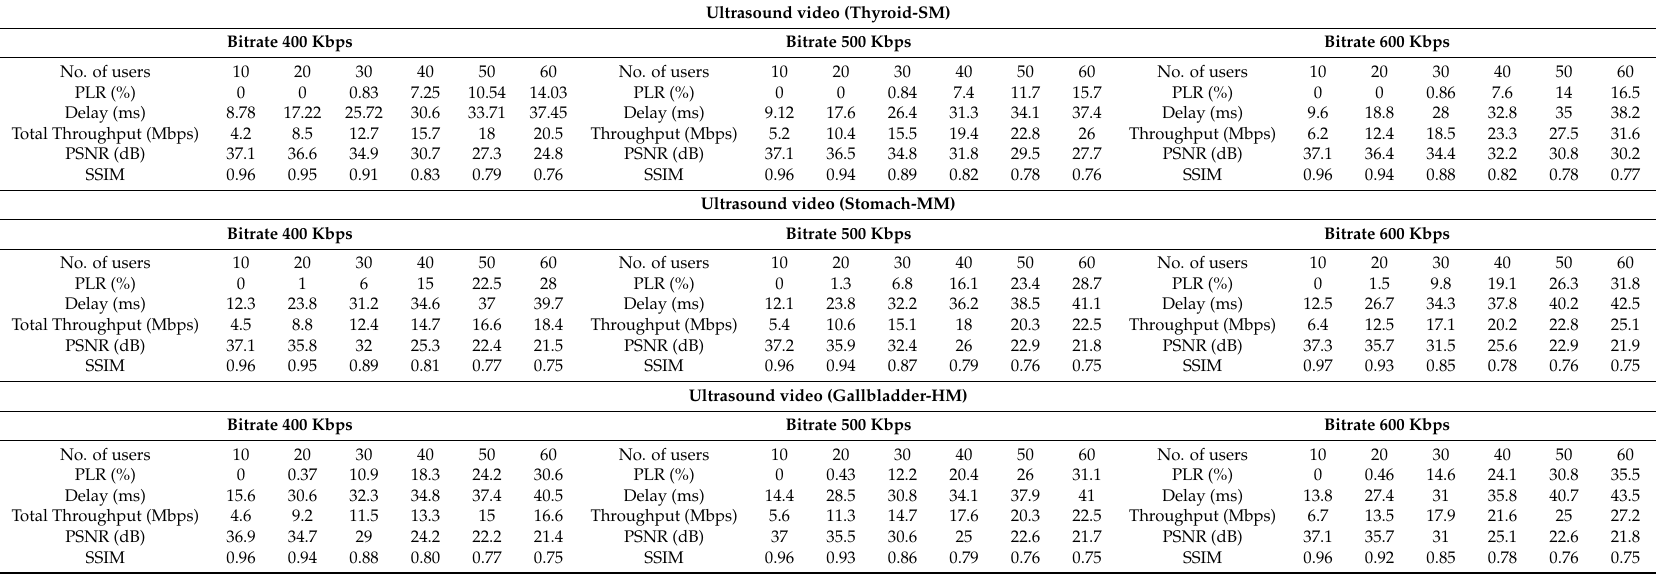
Table 3. m-QoS results over small cell